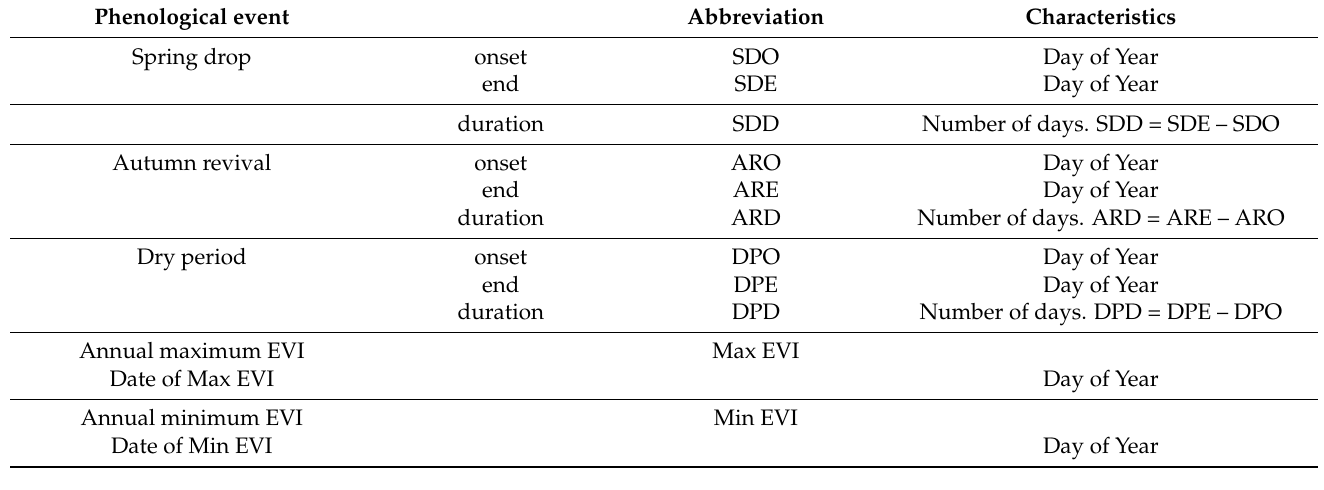
Table 1. Phenological events derived from the EVI curves, their abbreviations, and characteristics.